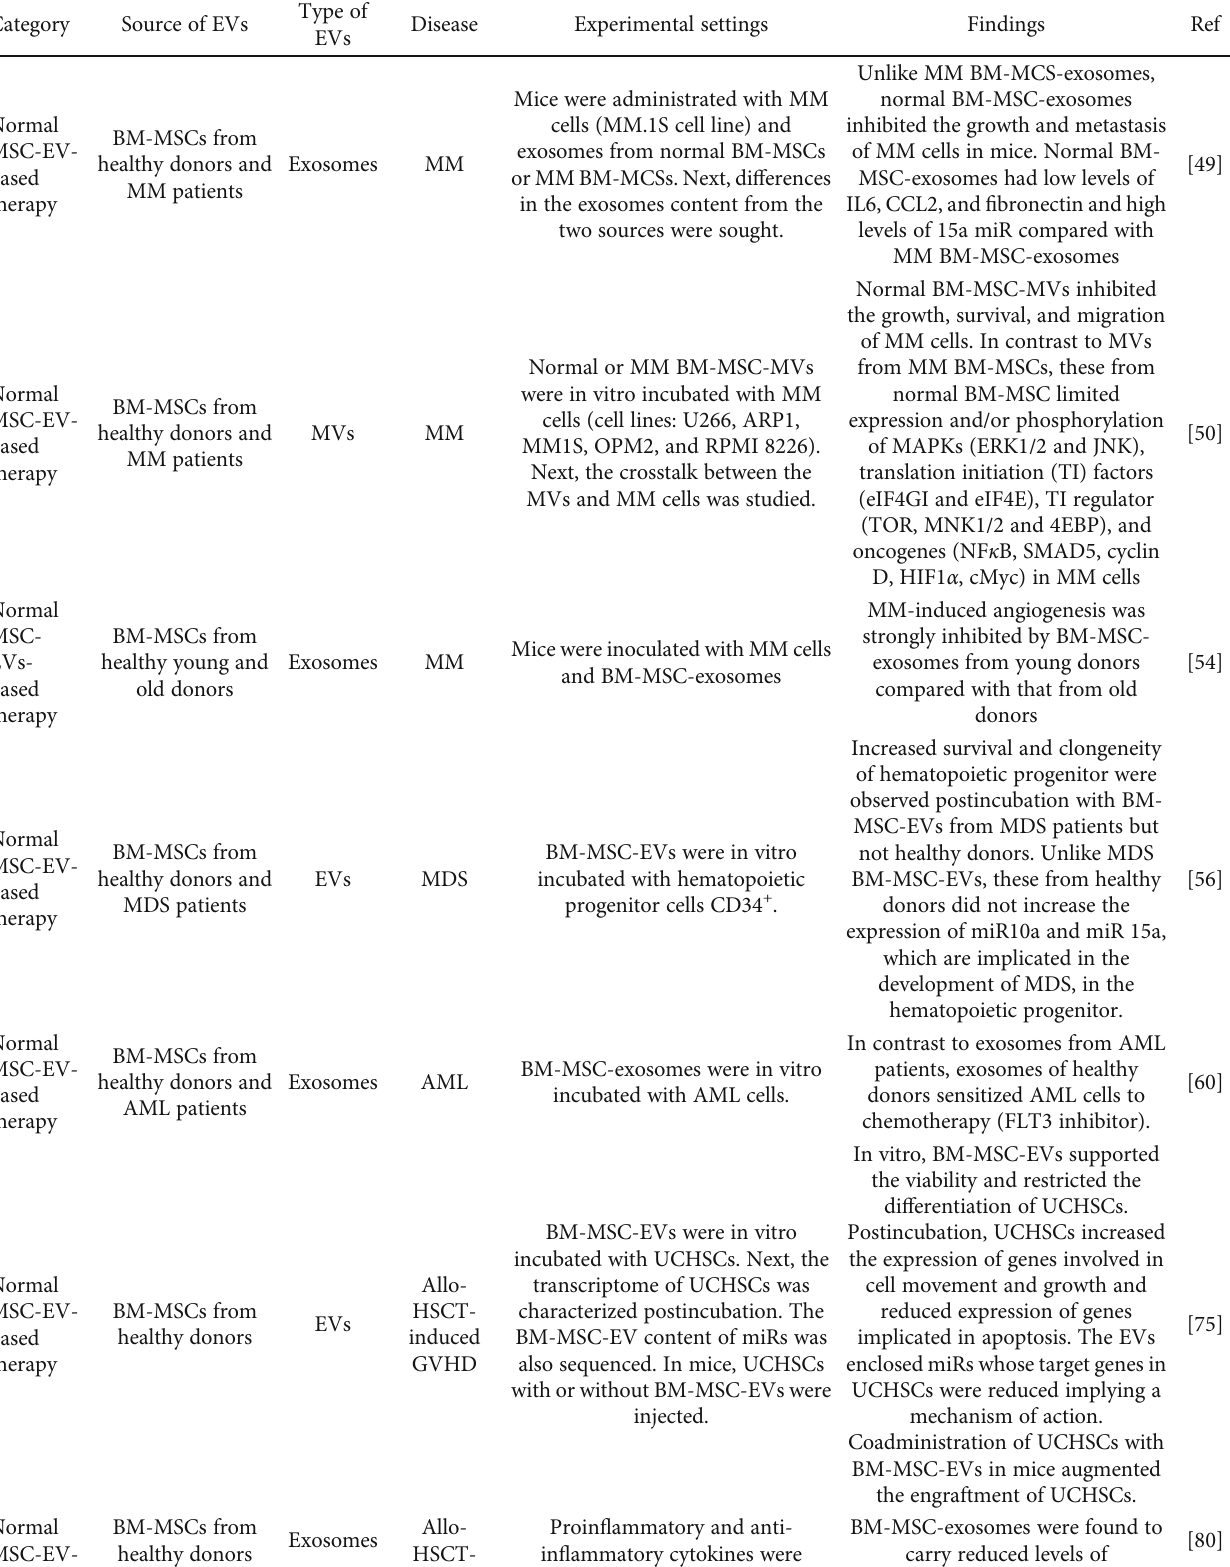
Table 1: Summary of the studies that investigated the potential of EVs secreted from MSCs and other kind of cells in the treatment of blood